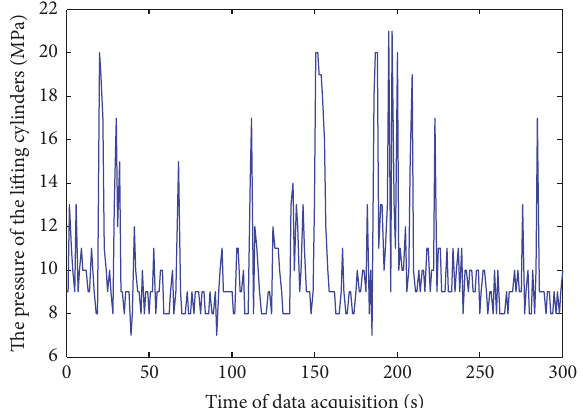
Figure 7: The pressure of the lifting cylinders.